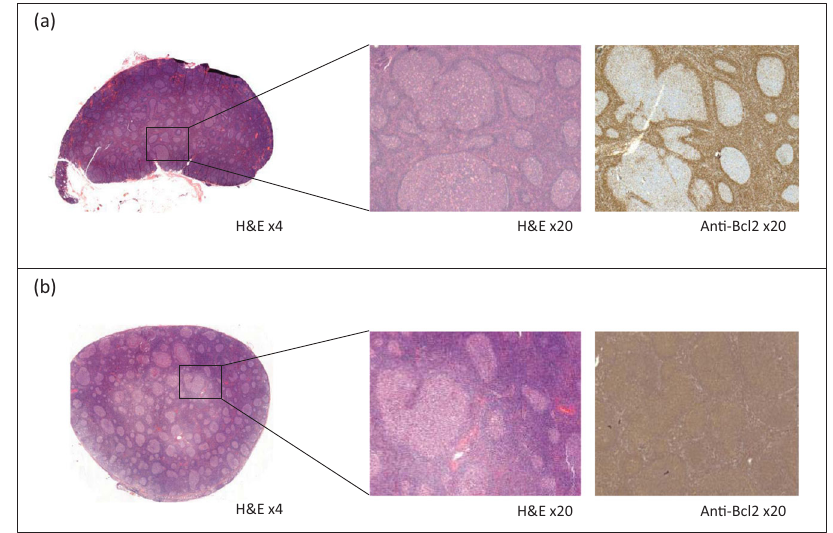
Fig. 1 Histopathological distinction between follicular hyperplasia and follicular lymphoma (FL). The distinction between reactive hyperplastic germinal centres ( a ) and FL ( b ) can be dif fi cult on haematoxylin and eosin (H&E)-stained slides making immunohistochemical stains mandatory for FL diagnosis: Bcl2 expression is down-regulated within reactive germinal centres ( a ) while it is expressed in the neoplastic cells in most FL cases ( b